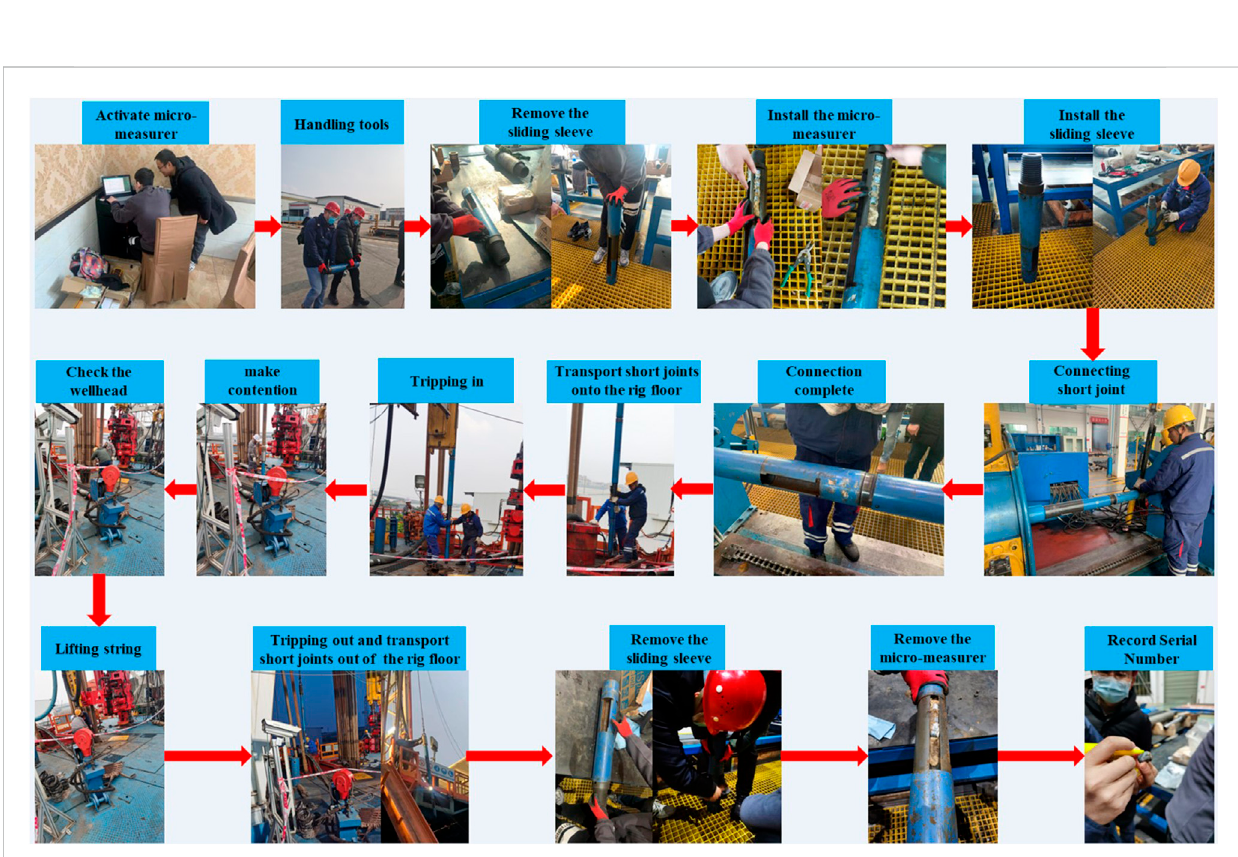
FIGURE 6 Field test process.